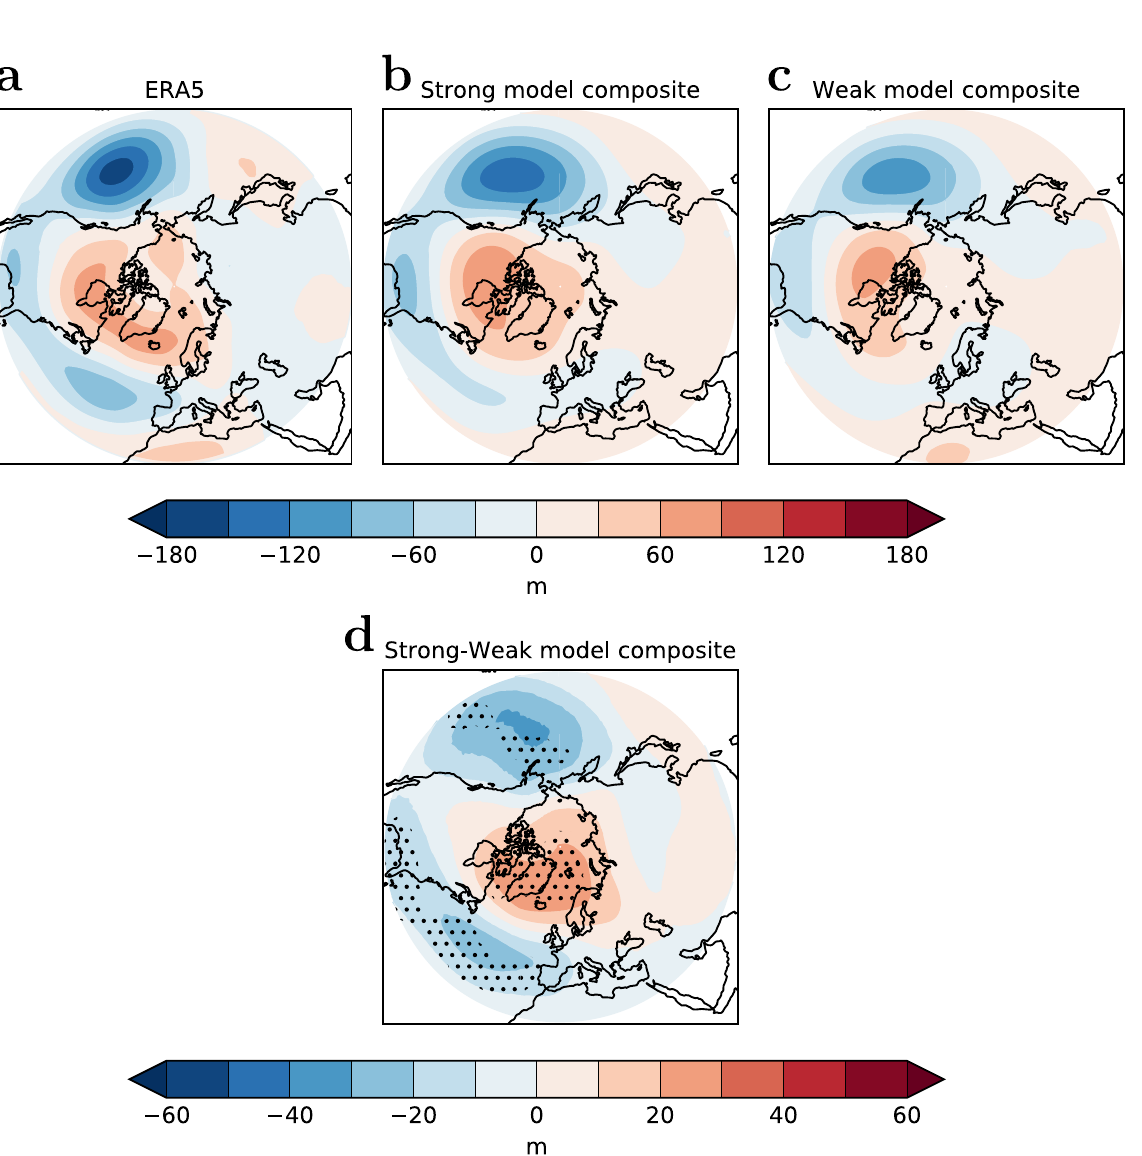
Fig. 2 ENSO teleconnection. ENSO anomalies of the 500 hPa GPH fi eld for a ERA5, composites over models with b strong and c weak eddy feedback 24 , and d the difference between strong and weak composites ( b – c ). ENSO anomalies are formed by taking GPH anomalies in El Niño years (Niño 3.4 index > 1.5K) minus those in La Niña years (Niño 3.4 index < 1.5K). Model composites based on eddy feedback are de fi ned in the Methods section. Stippling in d shows where the difference in model composites is statistically signi fi cant at the 95% level.